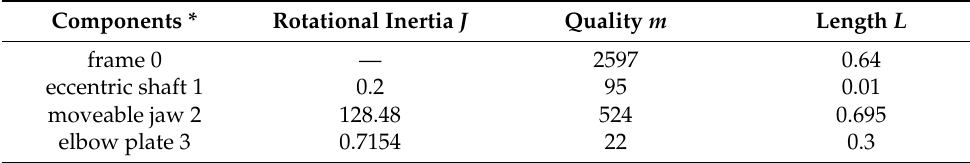
Table 1. Structural parameters of the jaw crusher mechanism. Components *